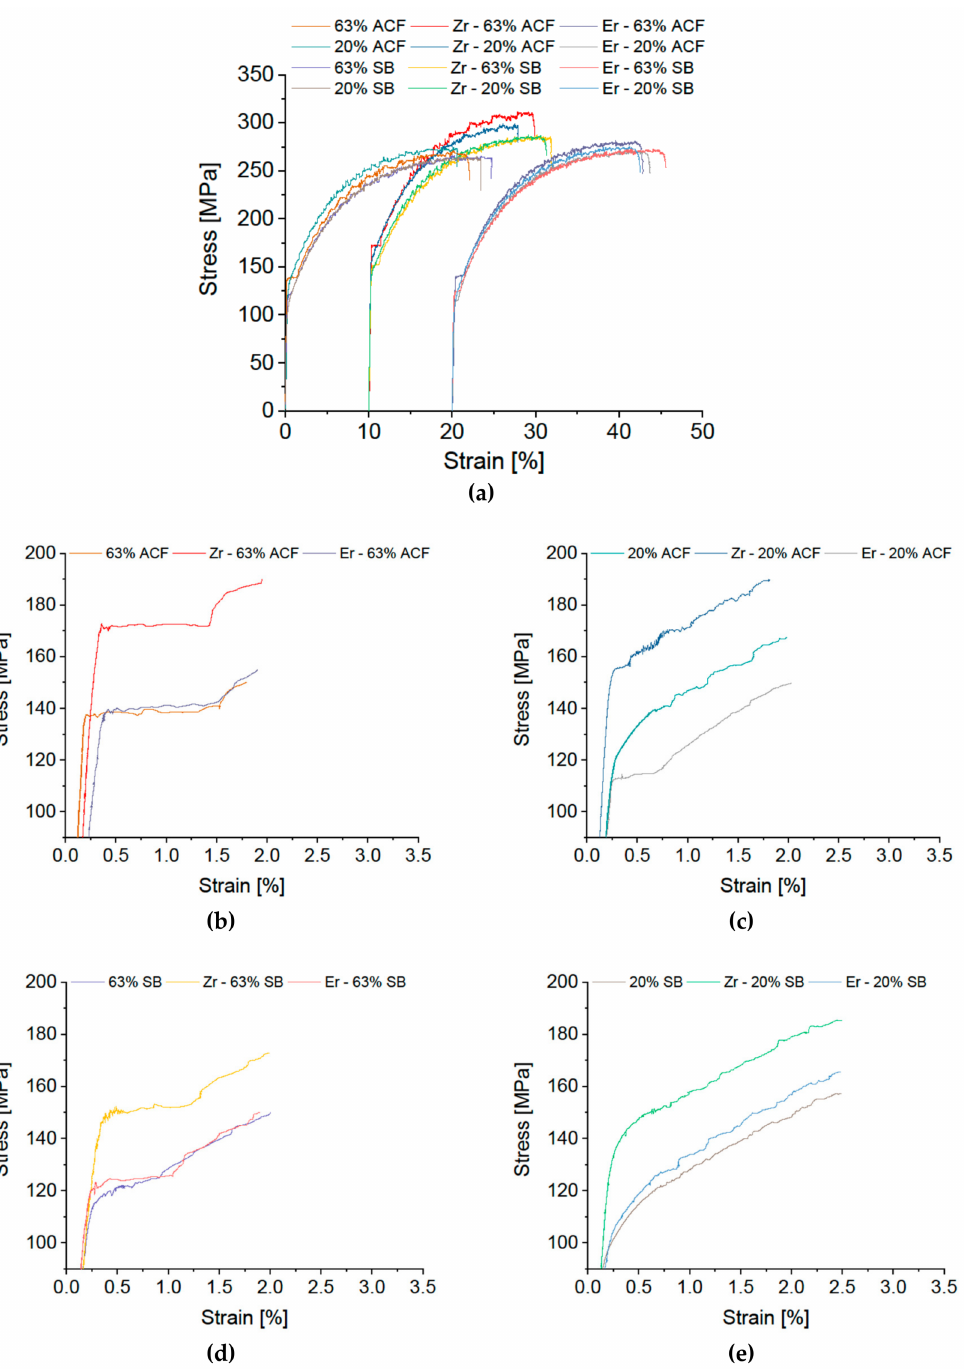
Figure 6. Stress-strain diagram of modified EN AW-5182 with additions of Zr and Er. ( a ) Overview; Details of Lüders elongation: soft annealing in ACF at 370 ◦ C with ( b ) 63% and ( c ) 20% cold rolling, salt-bath treatment at 500 ◦ C with subsequent water quenching with ( d ) 63% and ( e ) 20% cold rolling. Please note the di ff erent scale in ( b – e